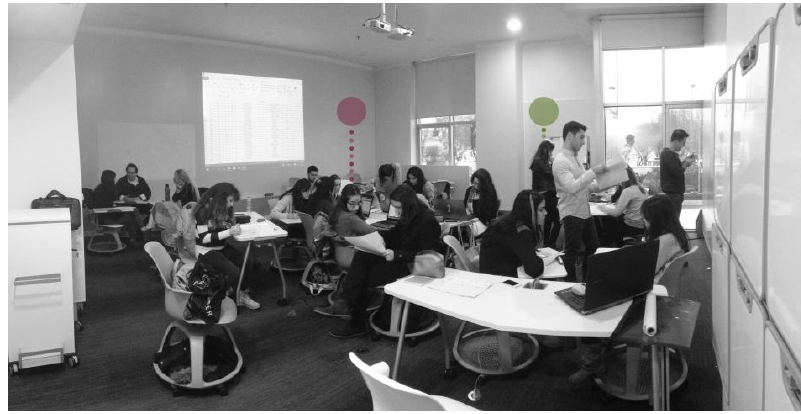
Figure 4. A photo from the workshop indicating randomly-selected participants for simulation.